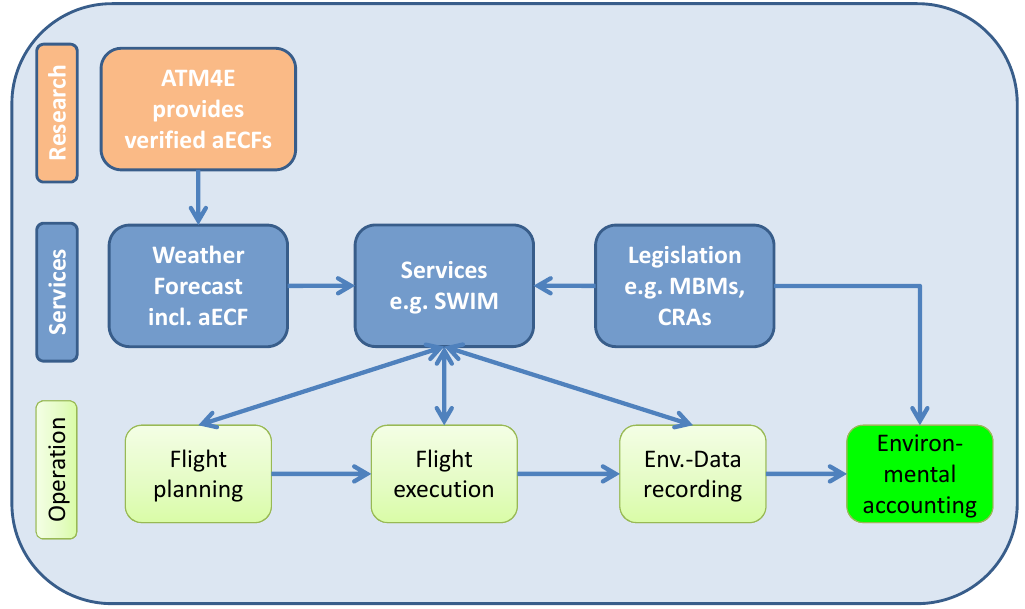
Figure 9. Overview on Air Traffic Management (ATM) infrastructure comprising environmental MET components as proposed by AMT4E (ATM for